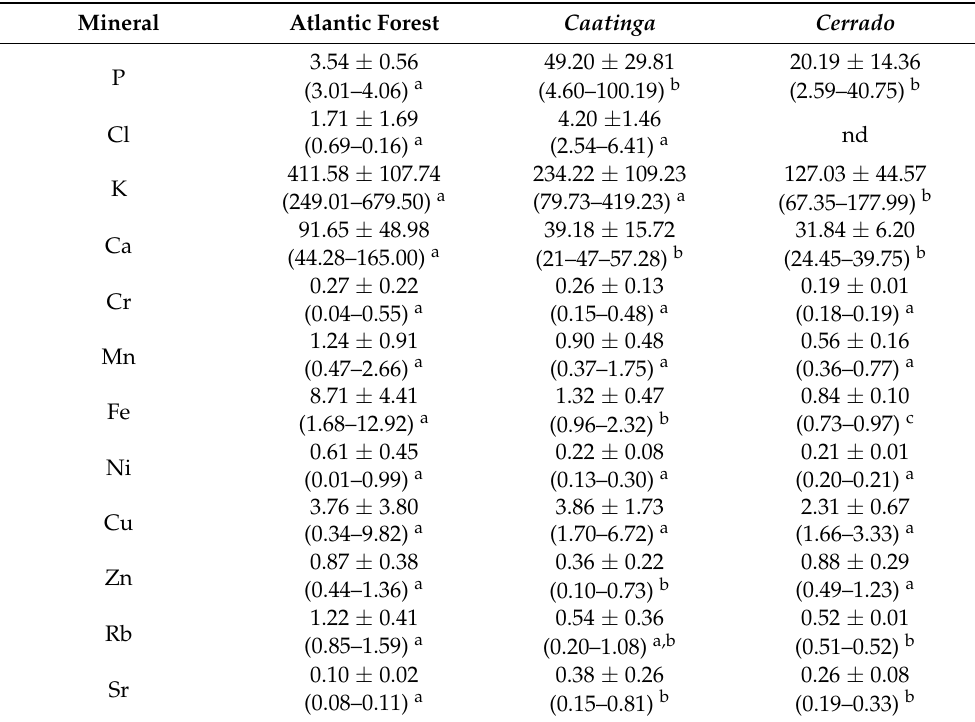
Table 4. Mineral profile of SBH from different Brazilian biogeographical zones. The results are expressed as mean concentration ( µ g/g FW) ± standard deviation. Minimum and maximum concen- trations are shown in parenthesis. Mineral Atlantic